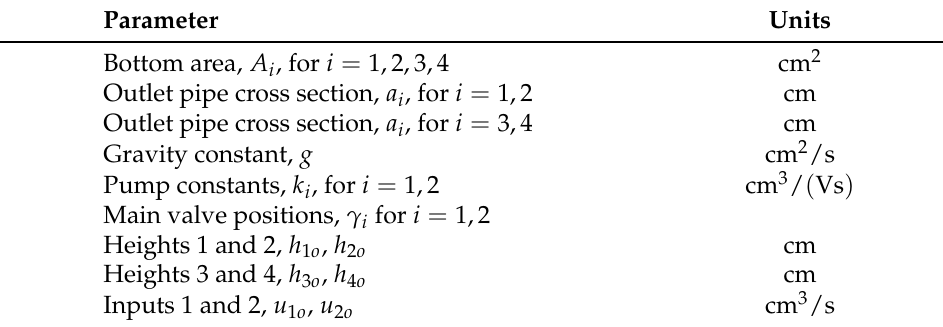
Table 1. Process Parameters.